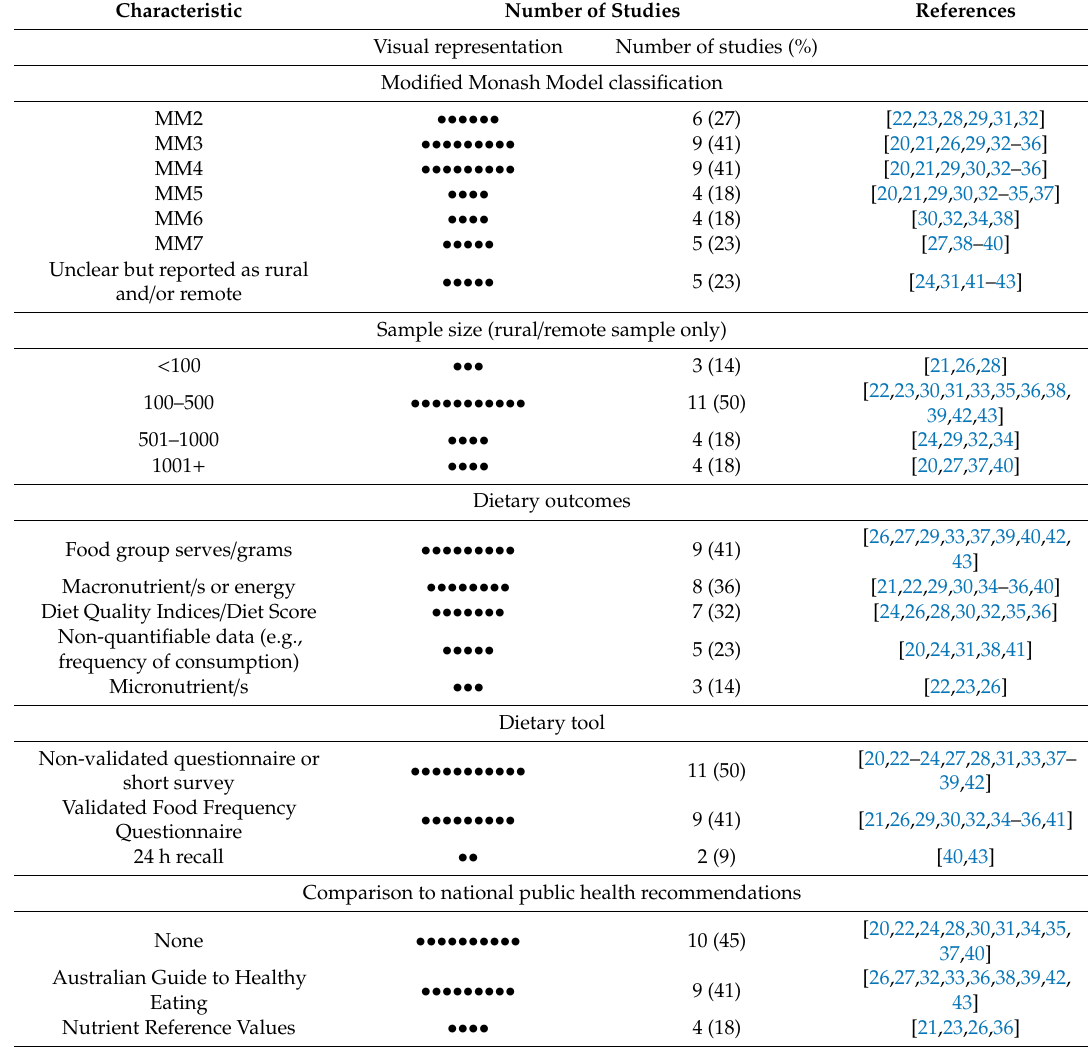
Table 2. Characteristics of included